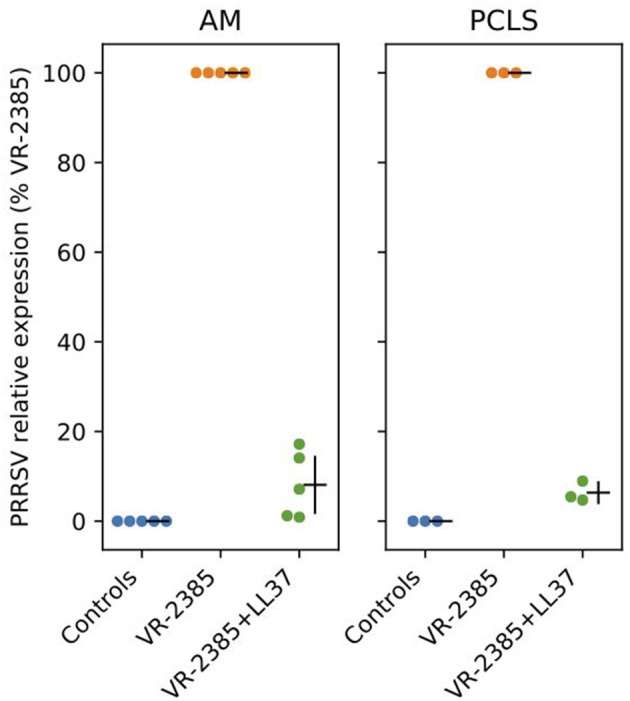
LL37 impacts on PRRSV replication in vitro. RT-qPCR was used to measure PRRSV VR-2385 replication after inoculation of the virus to AMs and PCLS in vitro with or without addition of LL37 (n = 3–5 pigs). AM, alveolar macrophage and PCLS, precision cut lung slices.